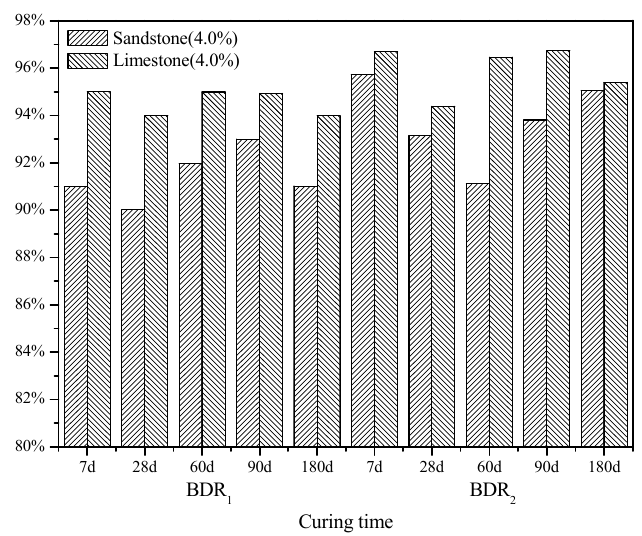
Figure 9. Relationship between the BDR and cement content.